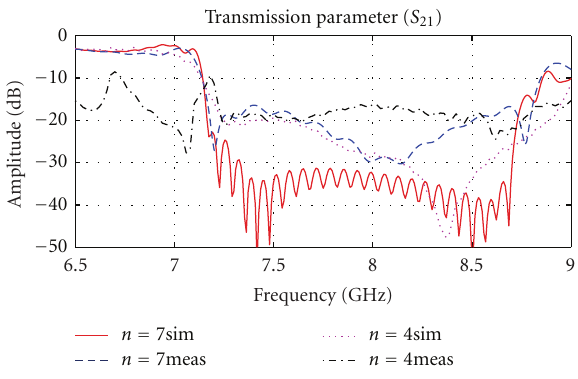
Figure 11: Transmission parameters ( S 21 ) for double layer mushrooms.